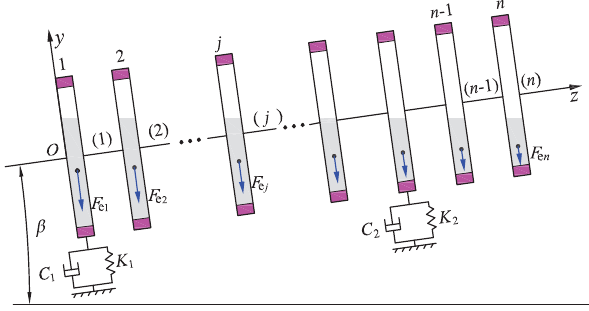
Figure 7. Lumped mass model of the concrete mixer rotating drum.